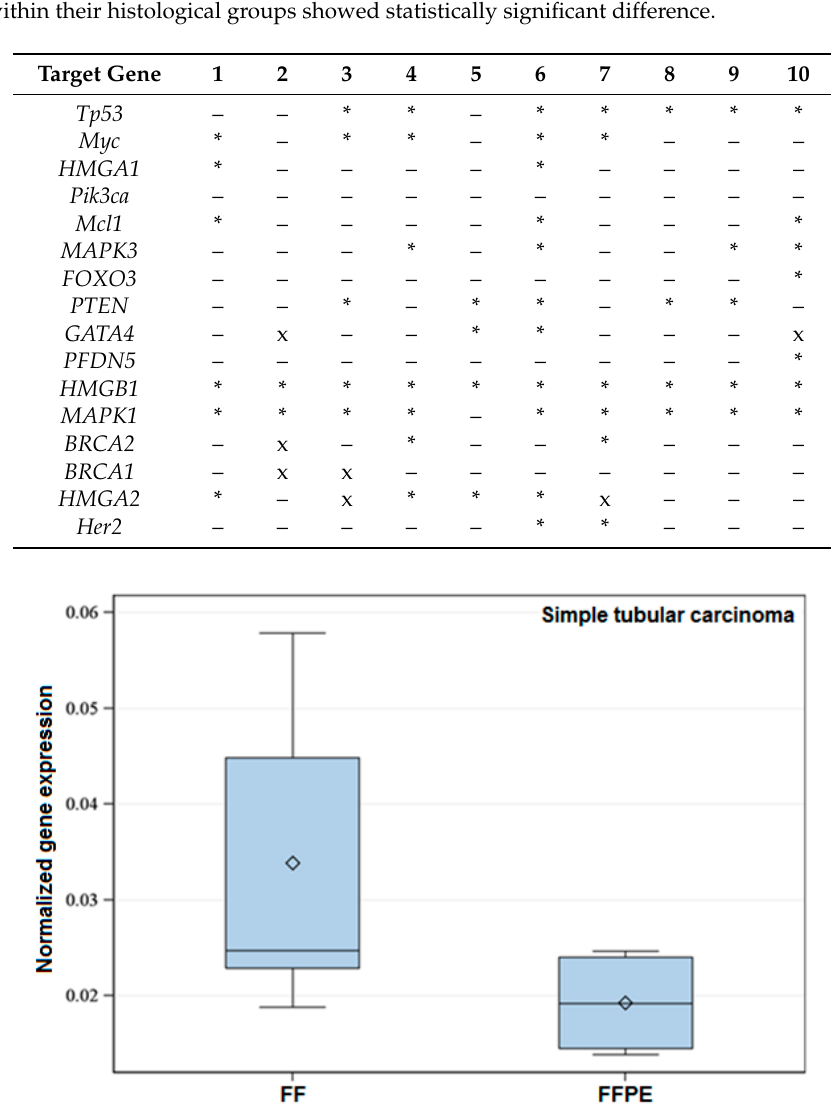
Table 2. Target genes and the histological groups: 1. healthy canine mammary tissue; 2. simple adenoma; 3. intraductal papillary adenoma; 4. complex adenoma; 5. benign mixed tumor; 6. simple tubular carcinoma; 7. solid carcinoma; 8. complex carcinoma; 9. ductal carcinoma and 10. carcinoma arising in a complex adenoma/mixed tumor. Asterisk (*) shows significant statistical differences ( p < 0.05) between the two origins of samples (fresh frozen (FF) and formalin-fixed, paraffin-embedded (FFPE)) when analyzing the target genes within the histological groups. x represents n < 4 (data were not considered). – represents no statistically significant difference. Fifty-seven of 153 (37.25%) of the genes within their histological groups showed statistically significant difference.